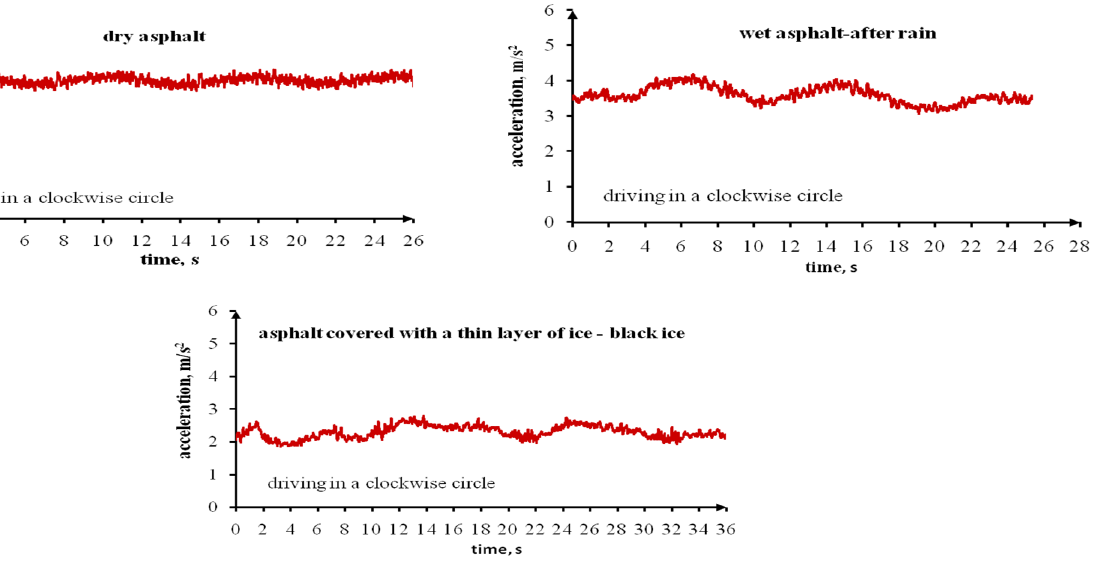
Figure 7. The Ford Transit’s lateral accelerations when driving in a circle clockwise (to the right), with the highest possible speed on a dry, wet (after rain) and icy asphalt surface. Table 10. The Ford Transit’s lateral accelerations and speeds when driving in a circle with the highest possible speed on a dry, wet (after rain) and icy asphalt surface.